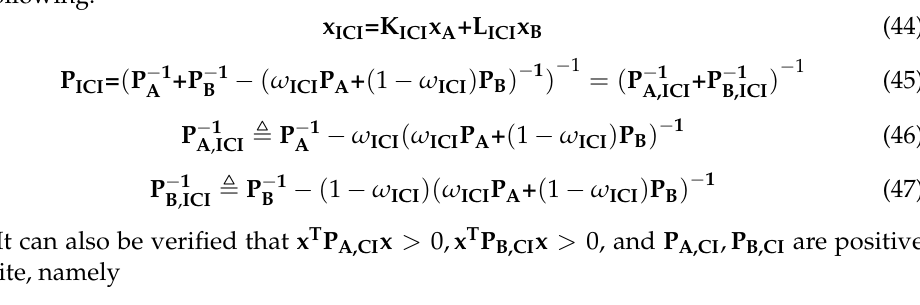
Figure 4. Comparison results of different covariance intersection fusion algorithms. ( a ) L = 4; ( b ) L = 5. Table 1. Value of covariance ellipse under L = 4 and L = 5. L = 4 L = 5 P1